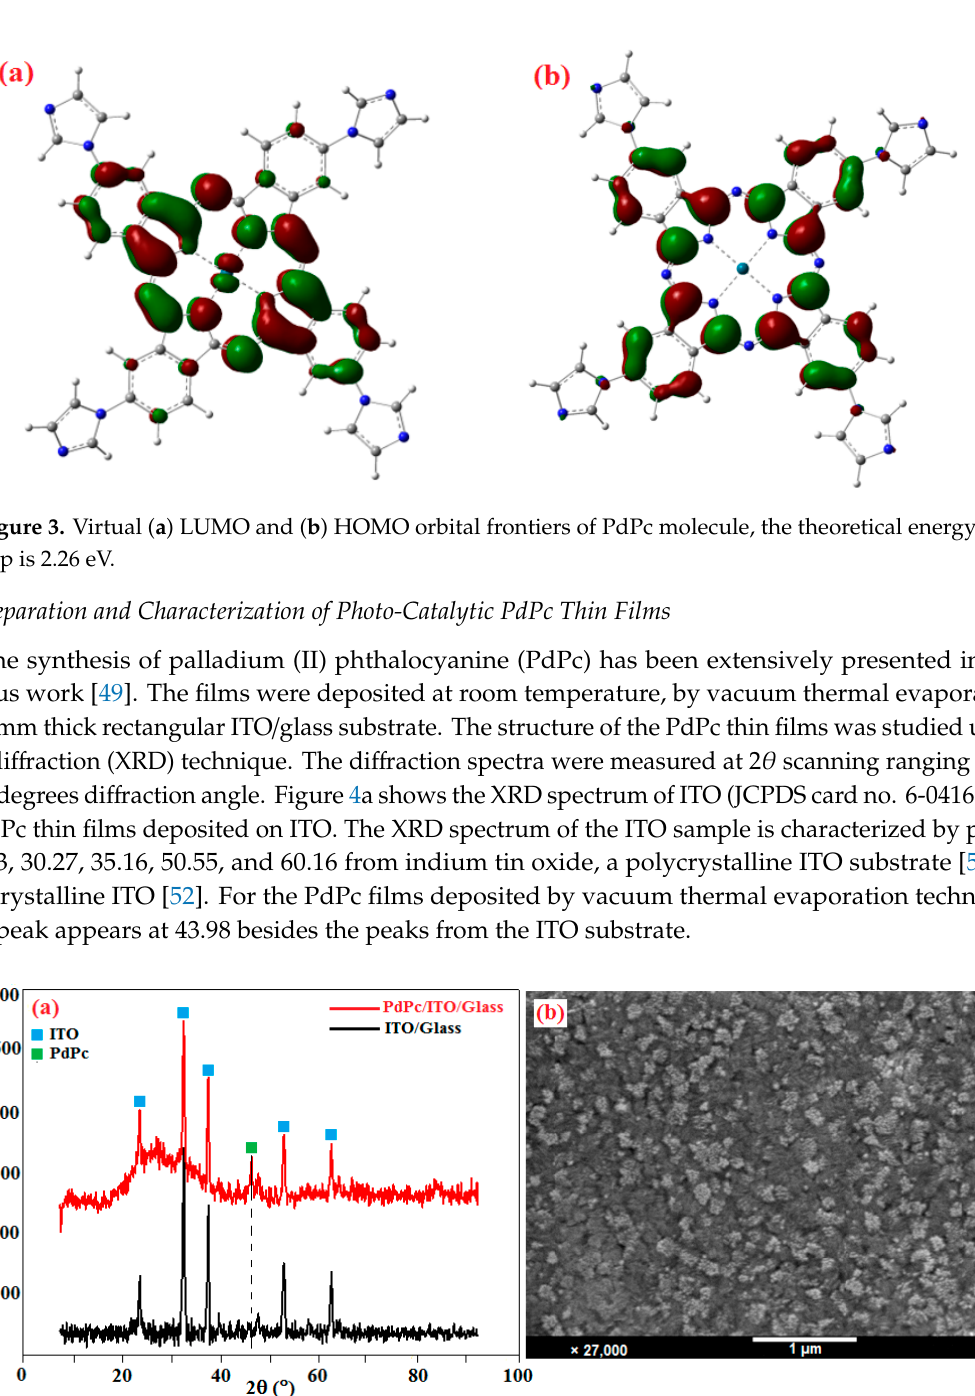
Figure 3. Virtual ( a ) LUMO and ( b ) HOMO orbital frontiers of PdPc molecule, the theoretical energy gap is 2.26 eV.